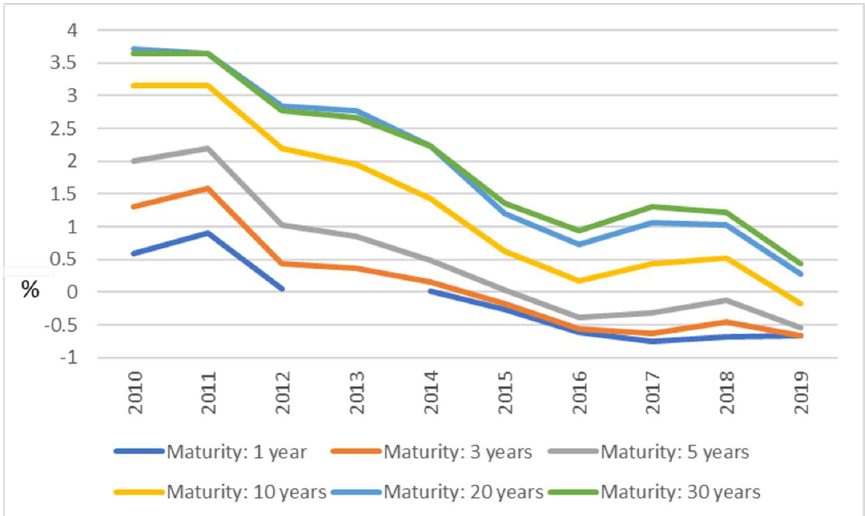
Figure 1. Euro yield curves-annual data 2010–2019 (euro area). Source: Authors’ construction using database of Eurostat .